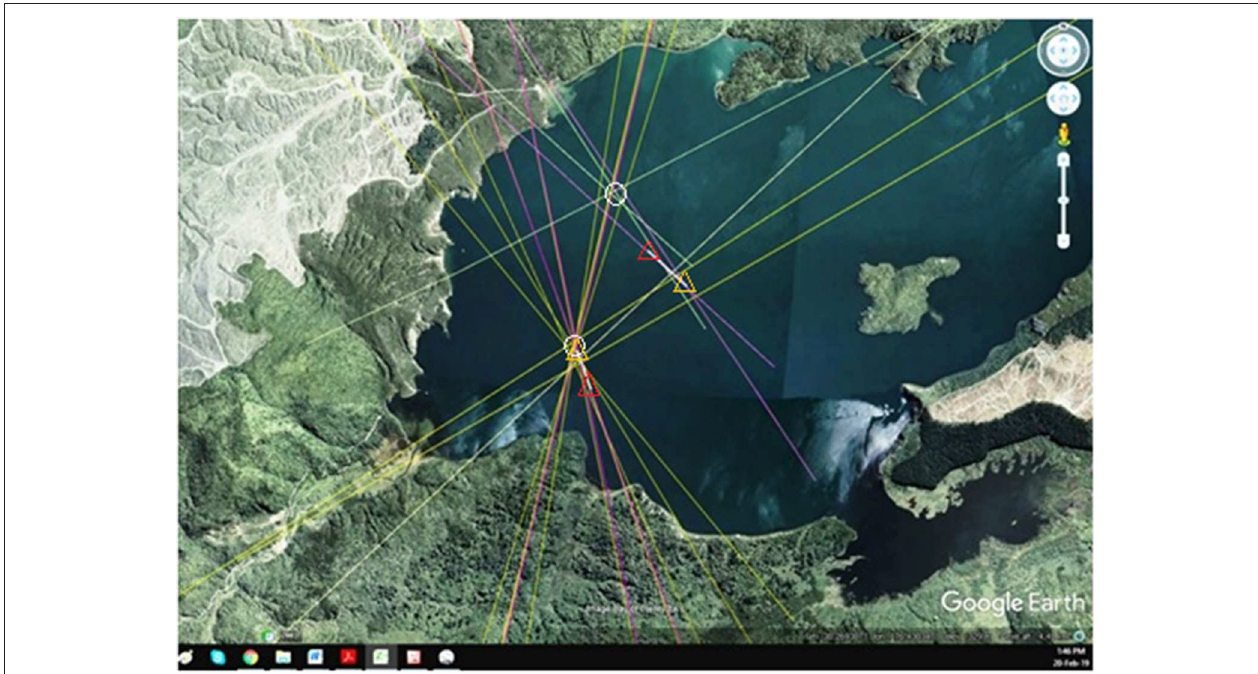
FIGURE 1 | Station 21 and Puai Station coordinates by LW-2018b, with Bunn 2018-2019b (Google Earth TM /Bunn 2019). LW-2018b-3 purple rays resect Station 21. 2 light-purple rays resect Puai station. White rays measure gaps between actual and stated locations. Orange Triangles mark LW-2018b actual locations. Red triangles mark LW-2018b stated locations. Bunn-11 yellow rays resect Station 21. 3 green rays resect Puai Station. White circles mark (Bunn, 2019a,b) observation station coordinates. Note: LW-2018b actual Station 21 location is proximal to Bunn (2019a,b) locus, while their stated location is distal. Both LW-2018b stated and actual Puai coordinates are displaced southeast. Their actual error is ∼